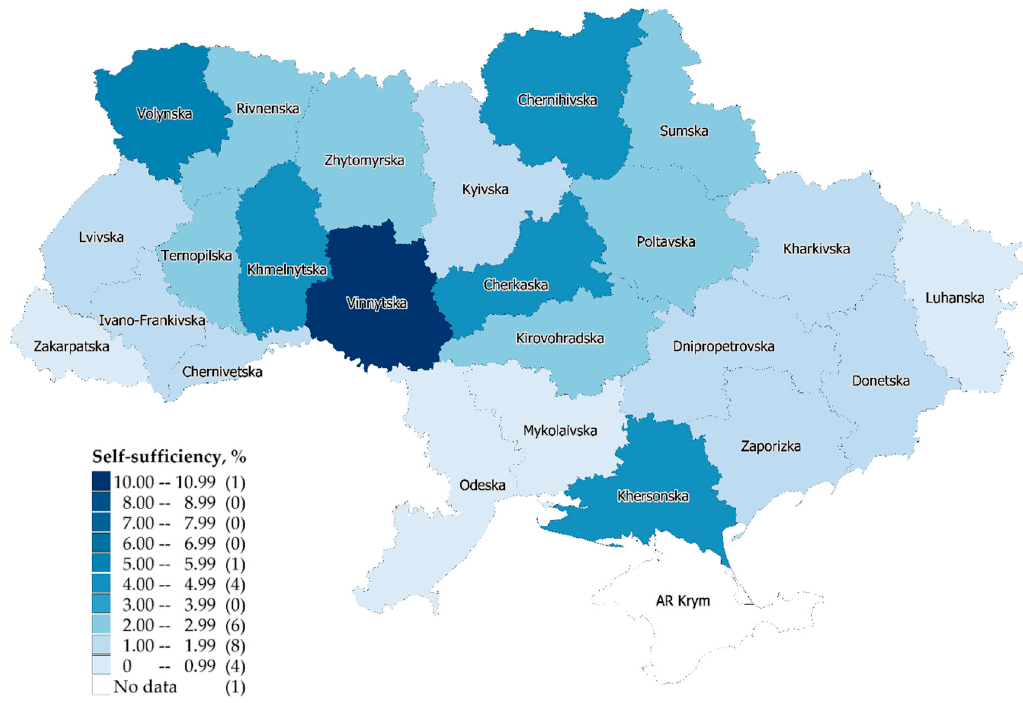
Figure 1. Potential self-sufficiency of biomethane from agricultural biogas plants. Source: own research.